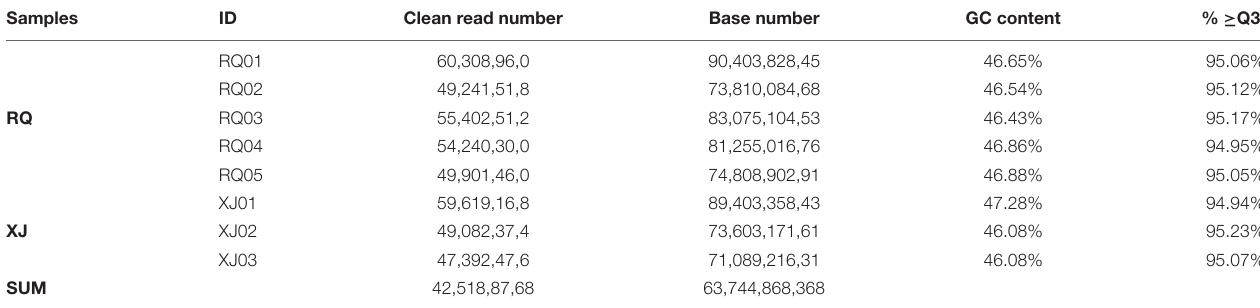
Sample abbreviations are defined in Table 1